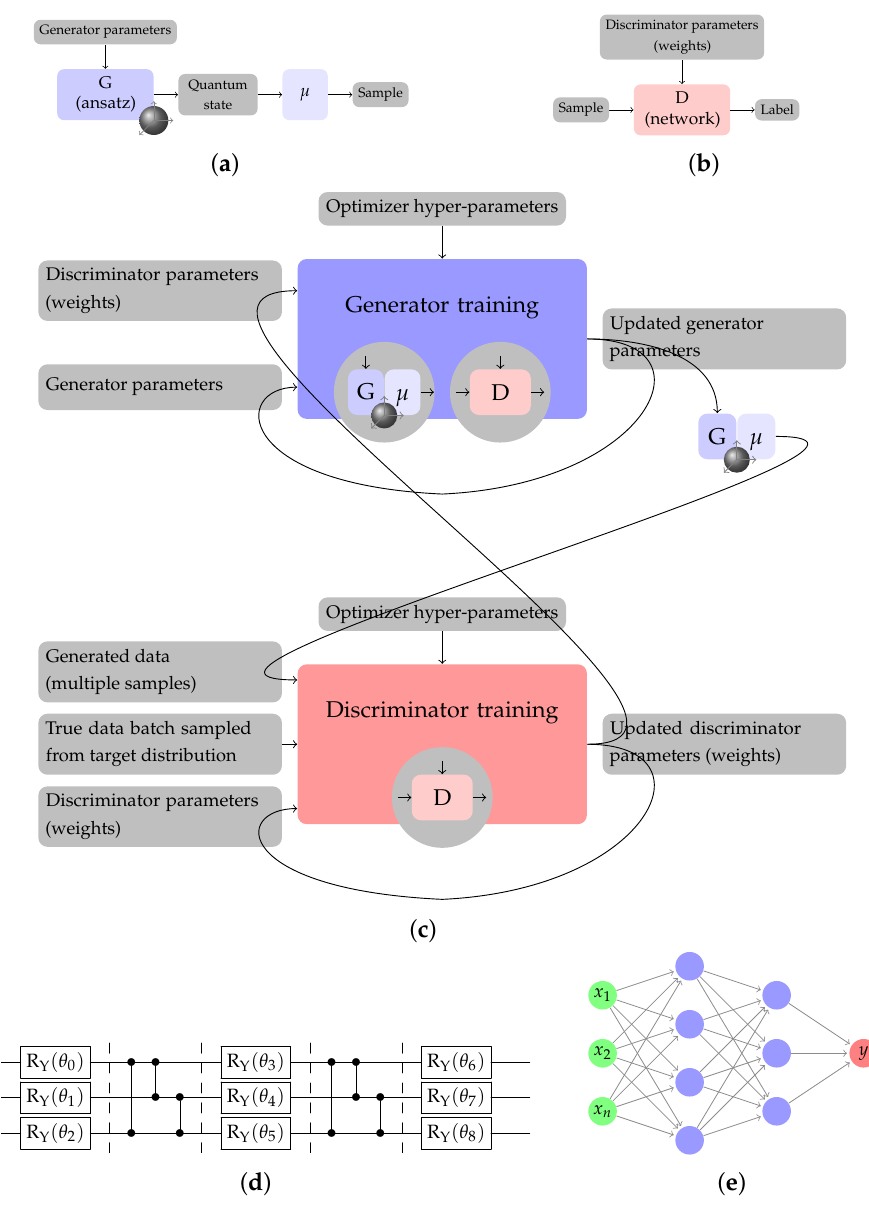
Figure 1. The schematic representation of the qGAN, composed by a generator quantum circuit and the discriminator neural networks. ( a ) In the case of a qGAN, the generator is an ansatz parametric quantum circuit. It produces a quantum state, in which squared amplitudes encode approximate probabilities. After measurement µ , it produces samples according to approximate probabilities. ( b ) A discriminator is a neural network that labels a sample as true or fake. ( c ) The training of a qGAN alternates the training of the generator and of the discriminator. The generator training has access to both the generator and the discriminator, but not to true data. Conversely, the discriminator training has no direct access to the generator, as it works by comparing generated data with true data. Quantum data are marked by a Bloch sphere. ( d ) The ansatz is a layered quantum circuit based on qubits. Here, the ansatz for the case of n = 3 qubits and k = 2 repetitions is shown. Rotation layers are composed of RY gates, while entanglement layers are made of cZ . ( e ) The discriminative network is a classical deep neural network with two hidden layers. Activation functions are Leaky ReLU for the intermediate nodes, and a sigmoid for the